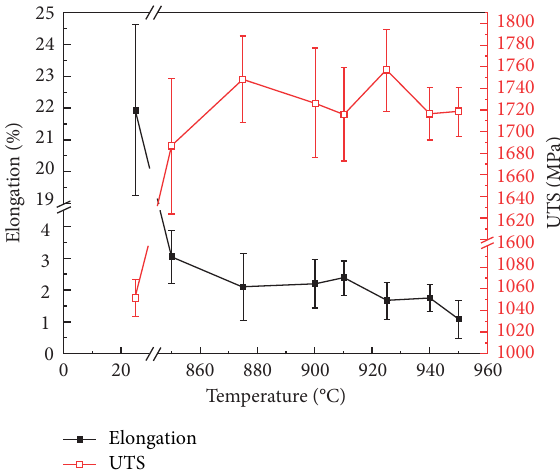
Figure 10: The tensile properties of specimens that underwent rapid heat treatment and